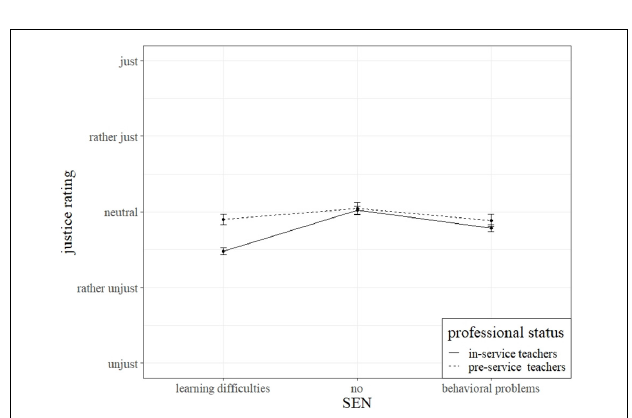
FIGURE 4 | Interaction of teaching experience and experimental